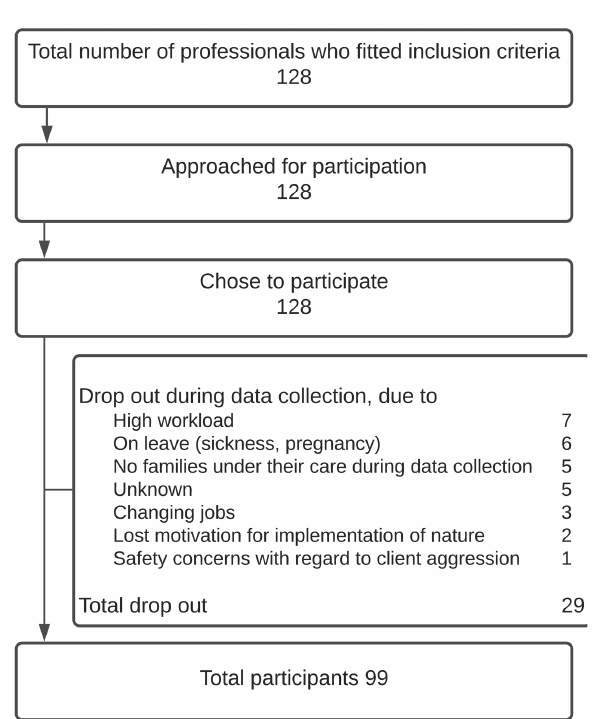
TABLE 1 | Participant